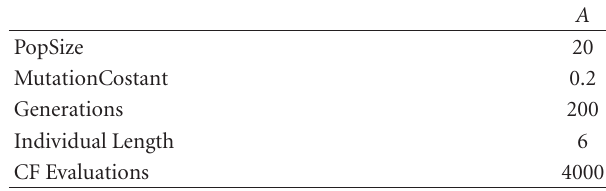
Table 8: Estimated parameters for DERand1Bin.